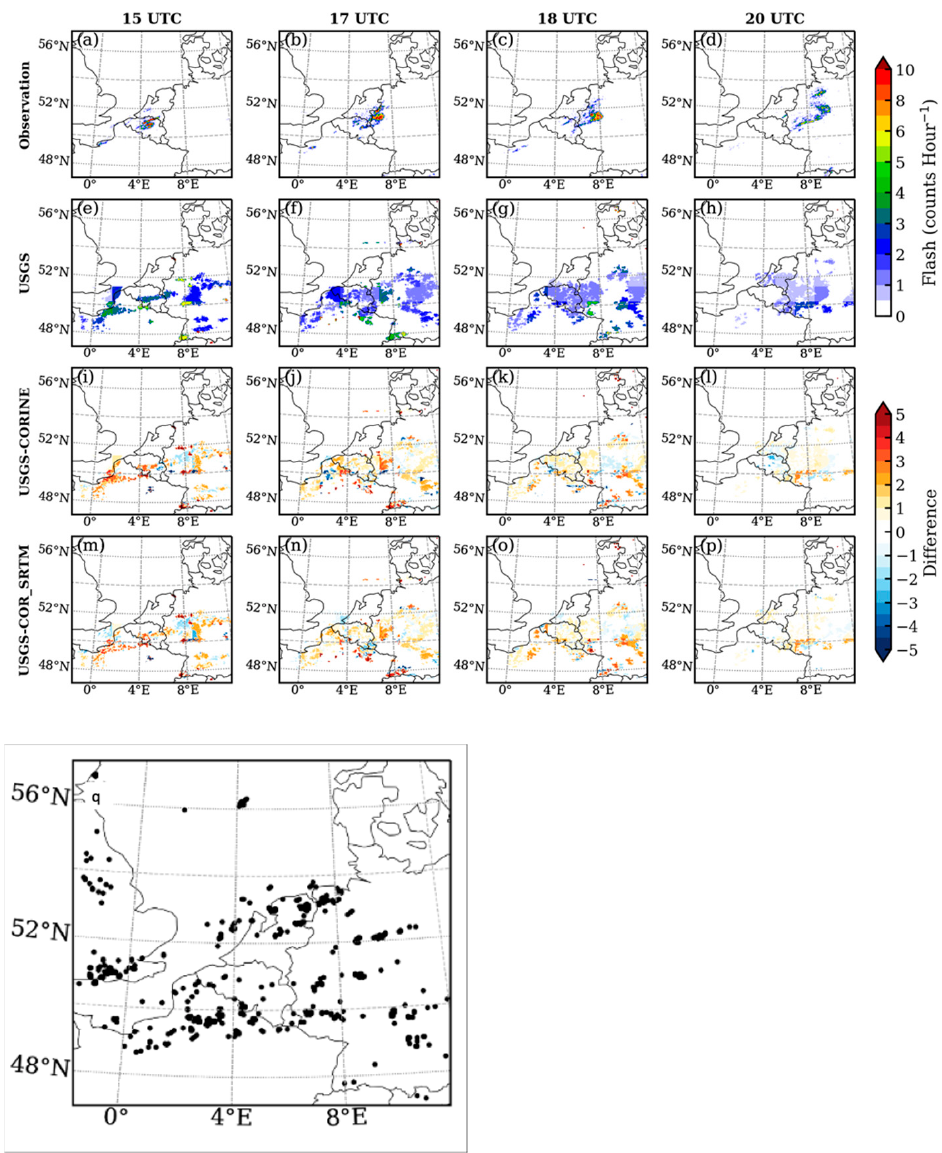
Figure 3. ( a ) The distribution of lightning flashes on 18 August 2011 at different hours (15, 17, 18 and 20 UTC) for ground-based observation (first row, a – d ) and USGS (second row, e – h ). The third row ( i – l ) shows the difference in the number of lightning flashes between USGS and Corine LULC, and the fourth row ( m – p ) shows the difference between USGS and Corine with SRTM. ( q ) Statistically significant differences (indicated with dots at a statistically significant difference at 95% level) between WRF_USGS and WRF_CLC for 18 August 2011 Case I based on Student’s t -test. In Figure 3a, the cloud-to-ground (CG) lightning flashes according to WRF_CLC, WRF_CLCS, WRF_USGS and observations are shown for 18 August 2011 at 15, 17, 18 and 20 UTC. Intracloud flashes were not considered in the analysis. CG lightning according to WRF_CLC, WRF_CLCS and WRF_USGS were calculated over parts of Belgium and the north-western part of France, which is in agreement with the observations. This indicates that the timing and the spatial distribution of CG lightning was well-represented by the model. Until 20:00 UTC, WRF_CLC, WRF_CLCS and WRF_USGS calculated no lightning flashes over the Netherlands, the southern of Paris, the eastern part of the UK, Luxem- bourg or over a large part of Germany, which is corroborated by the observations.